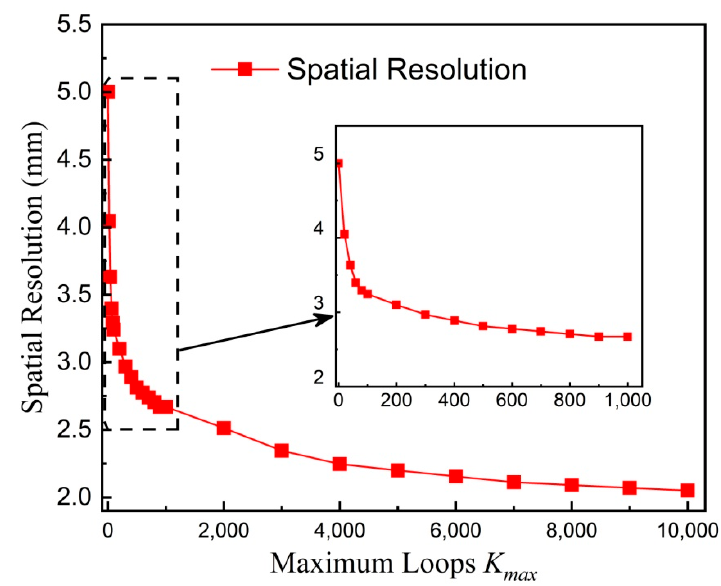
Figure 6. Modulation transfer function versus spatial frequency for different K max values. Symbols represent experimental results whereas solid lines are guides to the eye.